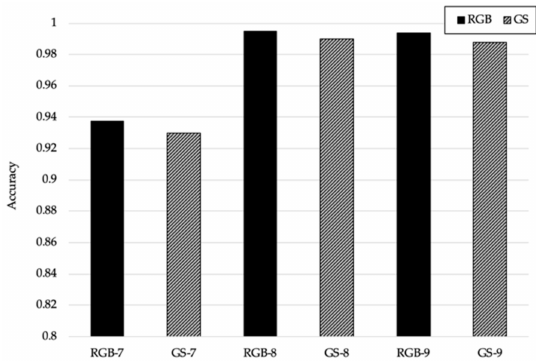
Figure 4. Accuracy Comparison of RGB and grayscale scenarios of CSE-CIC-IDS 2018.